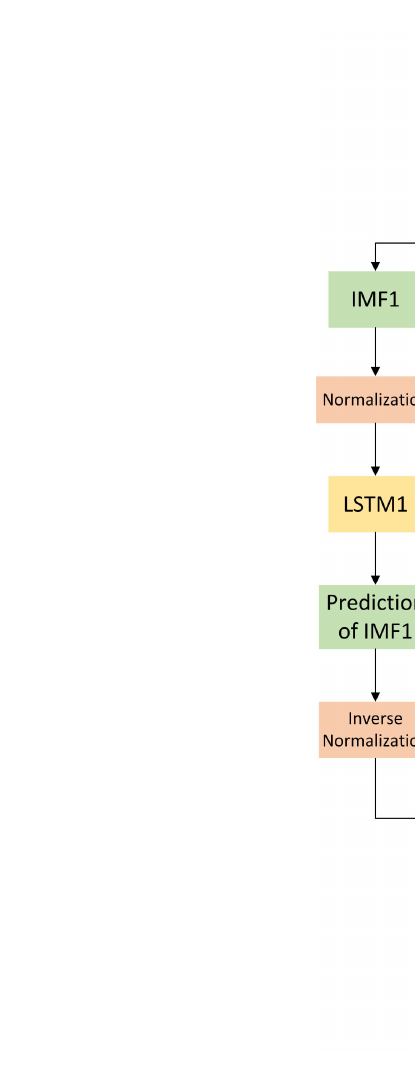
FIGURE 3 Flowchart of EEMD-LSTM model